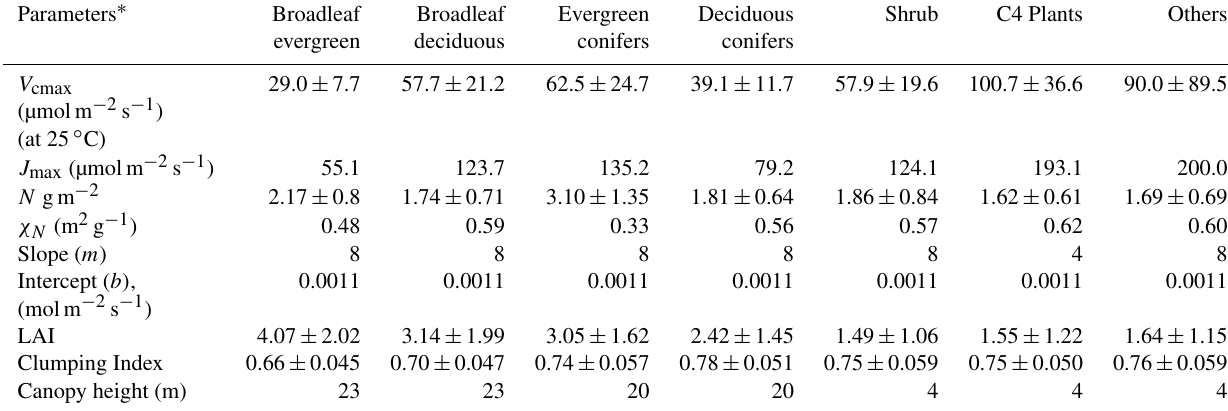
Table 1. Biophysical parameters are assigned by plant functional types in BEPS. References for the chosen values of these parameters are found in Chen et al. (2012).